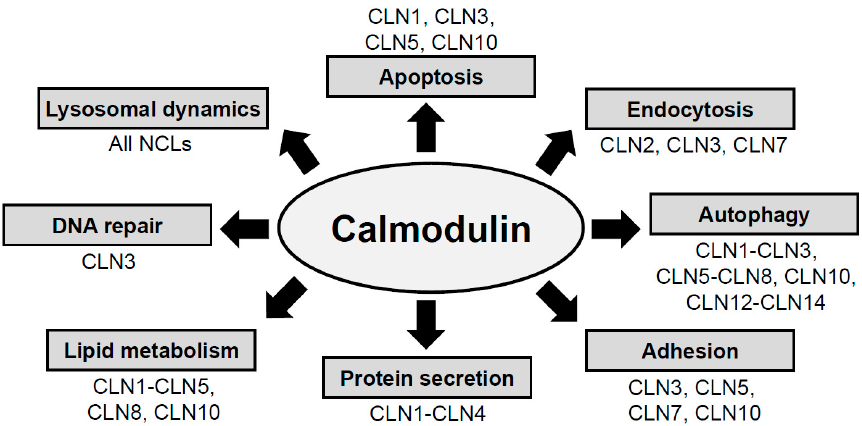
Figure 1. Calmodulin regulates a variety of cellular processes. In two articles—an early one by Chafouleas [27] and a recent one by Berchtold and Villalobo [28]—the diversity of calmodulin-regulated processes (boxed areas: lysosomal dynamics, apoptosis, endocytosis, autophagy, adhesion, protein secretion, lipid metabolism, and DNA repair, among others) were reviewed. For each of these processes, the NCL proteins that are linked to them are noted adjacent to the boxes (e.g., Apoptosis, CLN1, CLN3, CLN5, and CLN10).